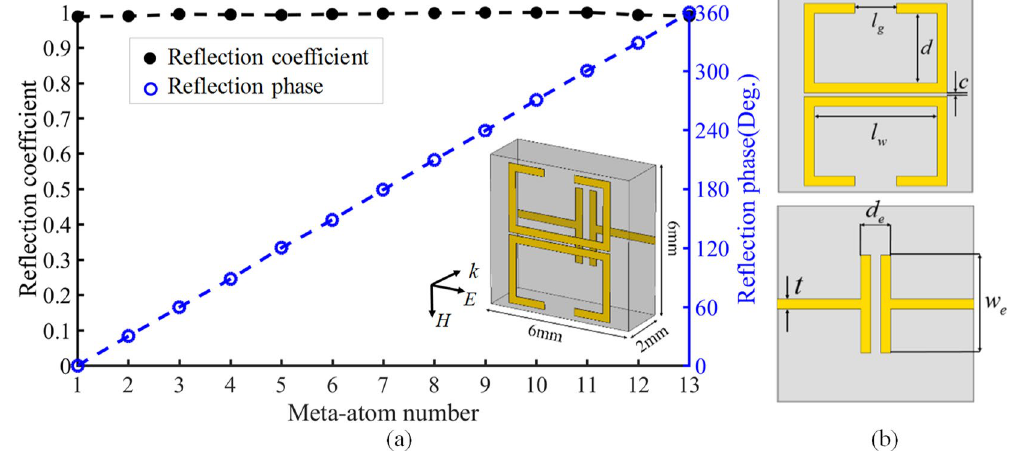
Figure 1. Schematic diagram and reflection characteristics of the proposed Huygens meta-atom. ( a ) Simulation results of reflection coefficients and reflection phase shift for meta-atom with different parameters. ( b ) Geometric parameters of the front view and back view of the meta-atom.